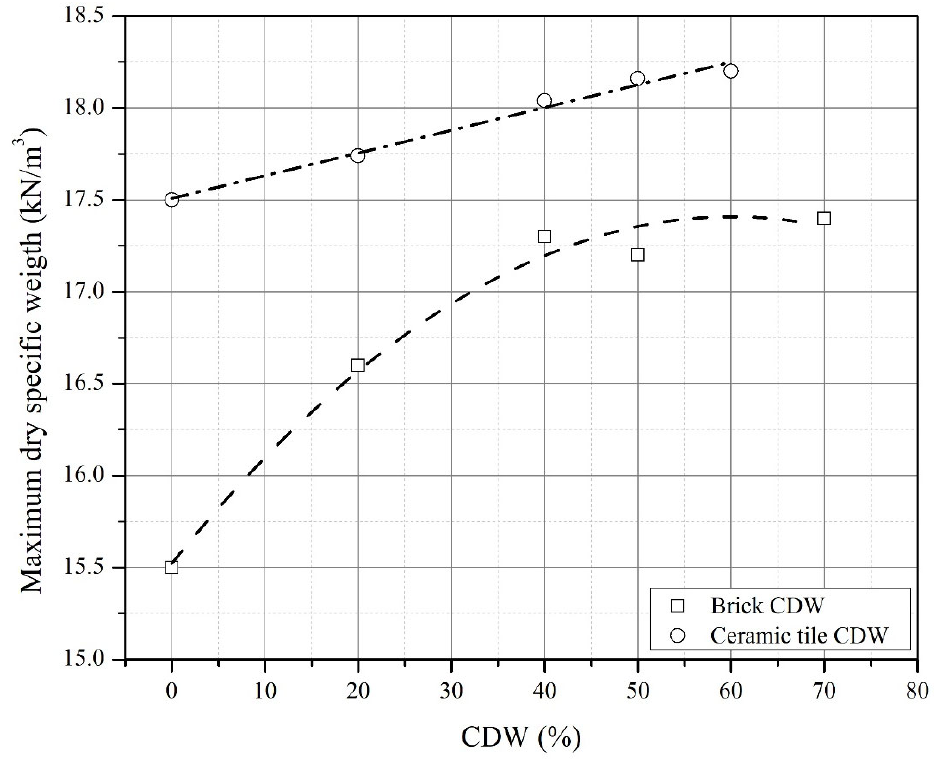
Figure 7. Relationship between maximum dry density and CDW content in the mixture.